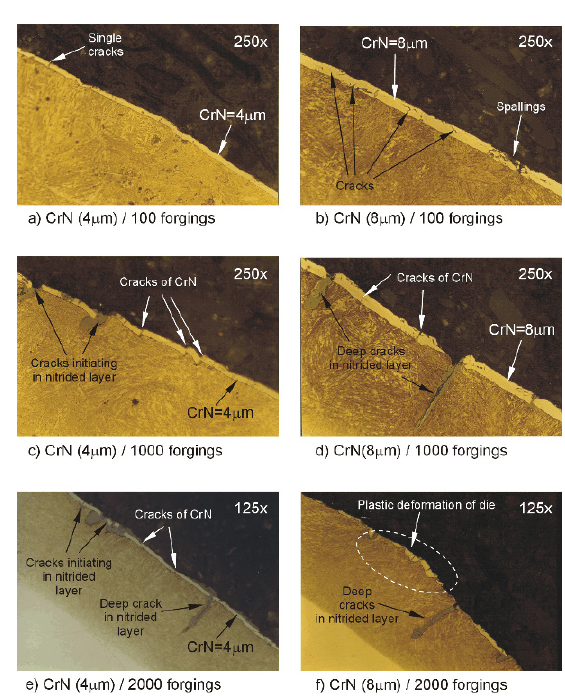
Figure 8. Comparison of the intensity of destructions in 4 µ m and 8 µ m thick CrN coatings for forging dies after the execution of 100, 1000 and 2000 pieces of